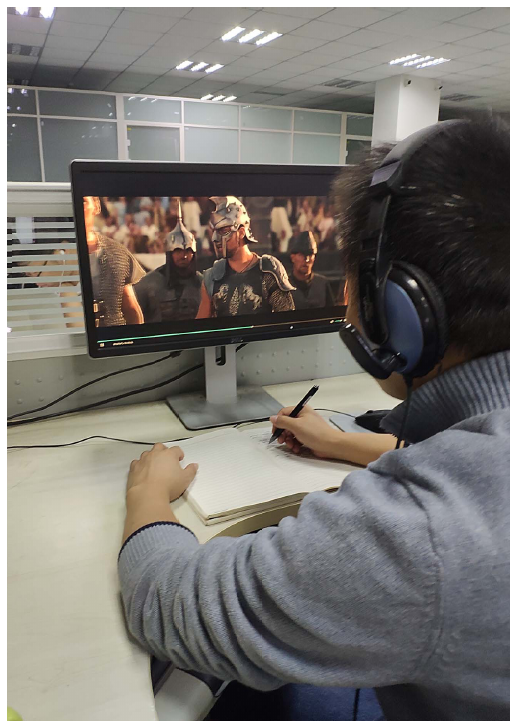
Figure 6. The process of dataset collection.